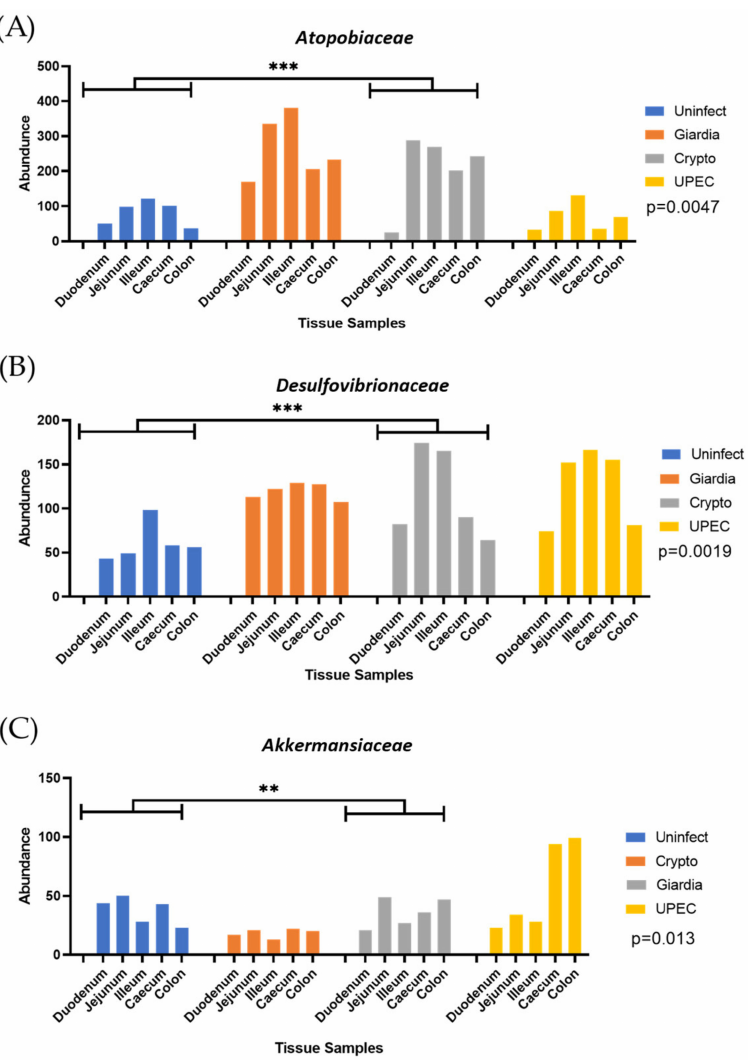
Figure 2. Relative population abundance of ( A ) Atopobiaceae, ( B ) Desulfovibrionaceae , and ( C ) Akker- mansiaceae bacterial species which showed the most significant changes amongst all genera observed during giardiasis with respect to other infections and uninfected condition, with significance of p ≤ 0.01 (***) and p ≤ 0.05